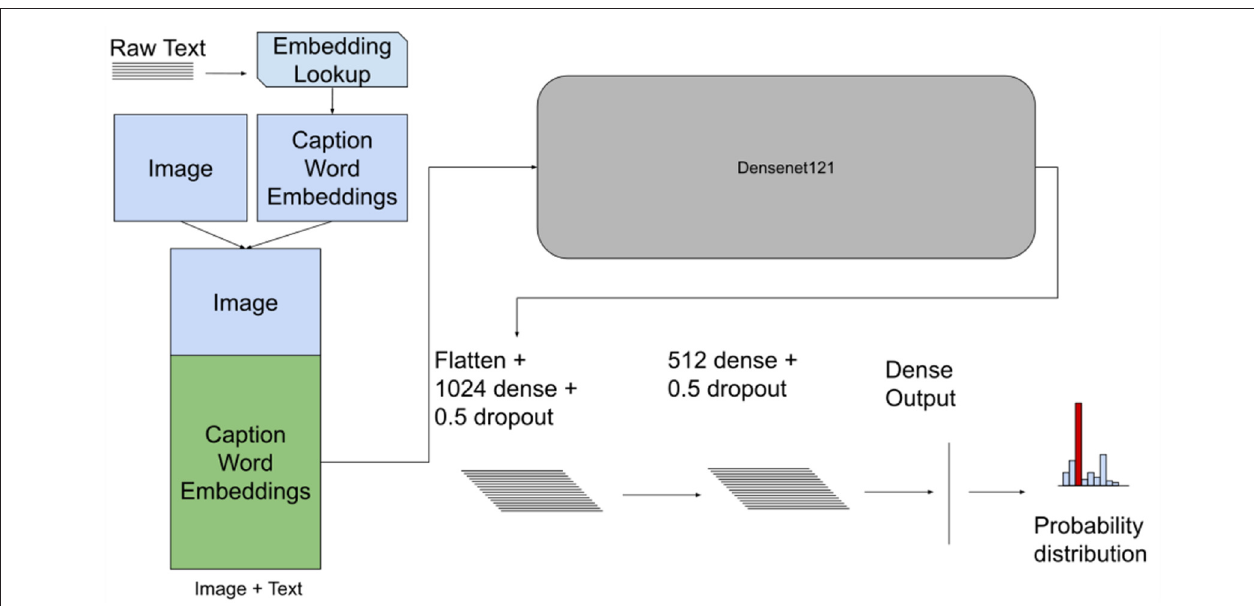
FIGURE 2 | Early fusion model architecture with the concatenated input image and text for both datasets. This model takes images and the embedding matrix for the associated text and concatenates them together. This new matrix is then passed to a CNN as an augmented